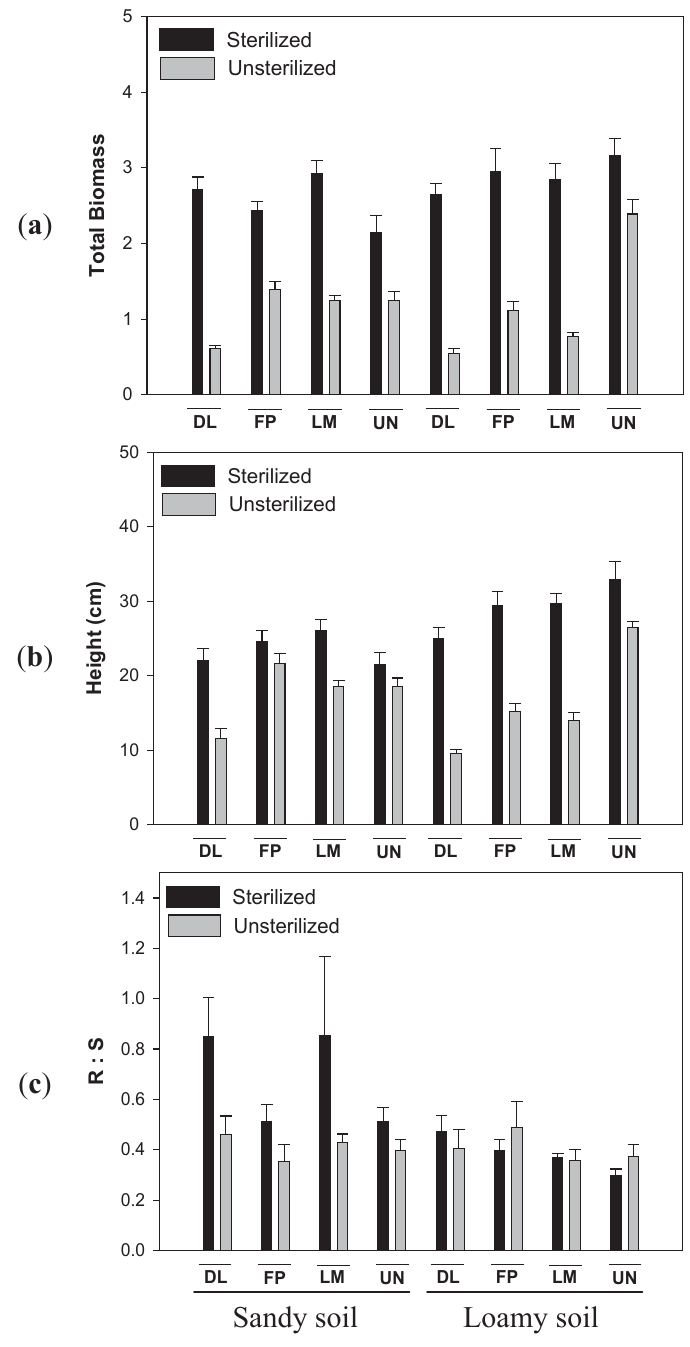
Figure 2: Mean (+ 1SE) ( a ) Total dry biomass; ( b ) end of season height; and ( c ) root/shoot ratio of Diervilla lonicera in response to soil sterilization and soil conditioning by three different species in two soil types. Conditioning treatments: DL = Diervilla lonicera